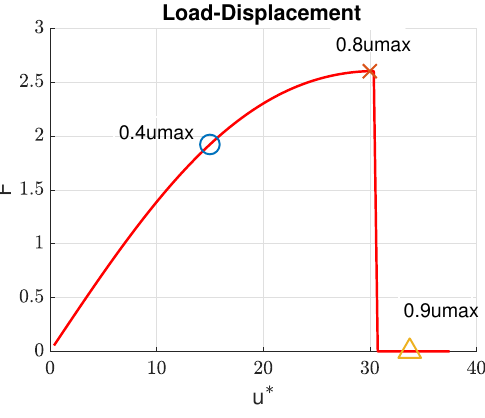
Figure 5. Load-displacement response of the bar for ( E 0 , G c ) = ( 3.705,4.332 ) .